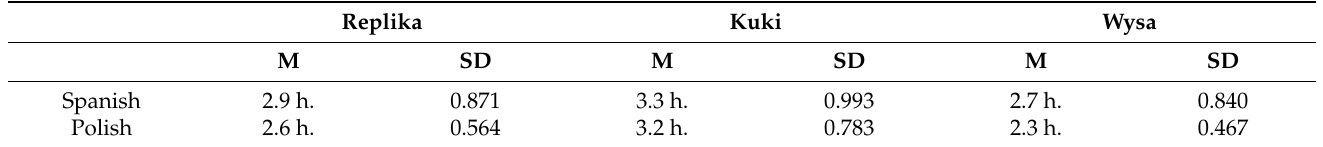
Table 4. Frequency of interaction (Choices: <1 h, 1–3 h, 3–5 h, 5+ h per week).